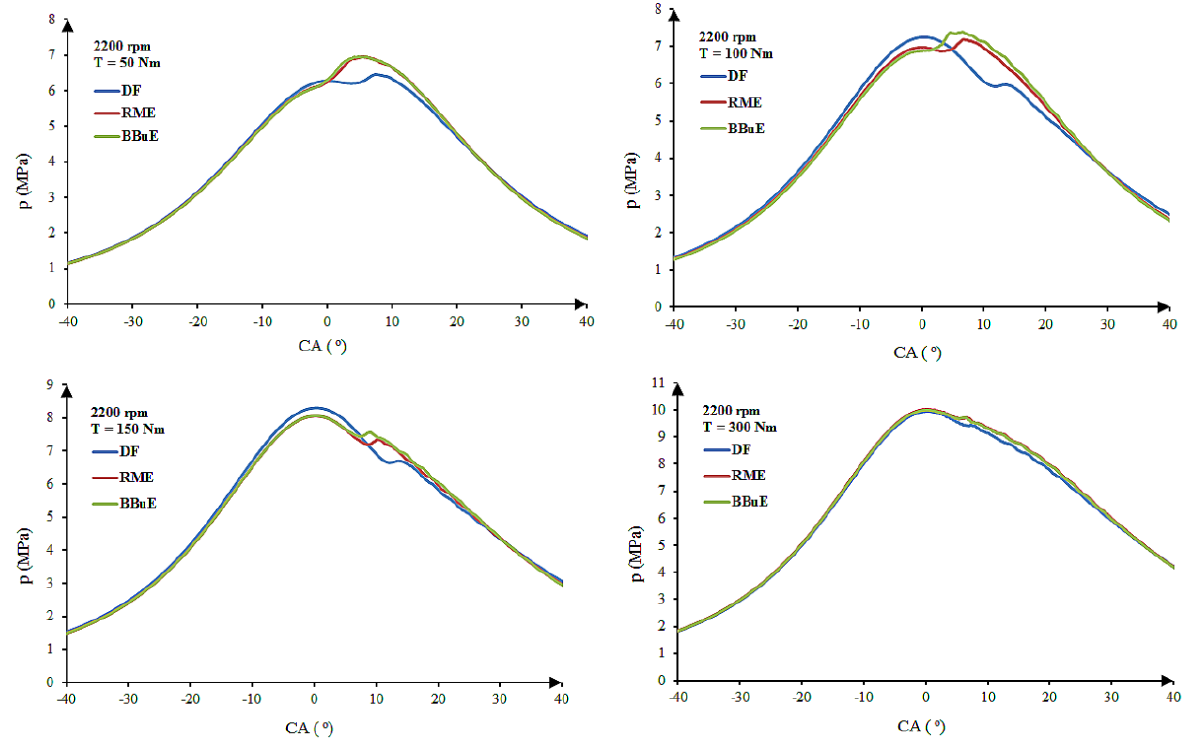
Figure 5. Examples of pressure profiles during the combustion of the tested fuels in the engine cylinder at its operation according to load characteristics.